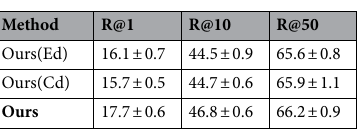
Table 7. Ablation studies of loss function on Fashion200k dataset.